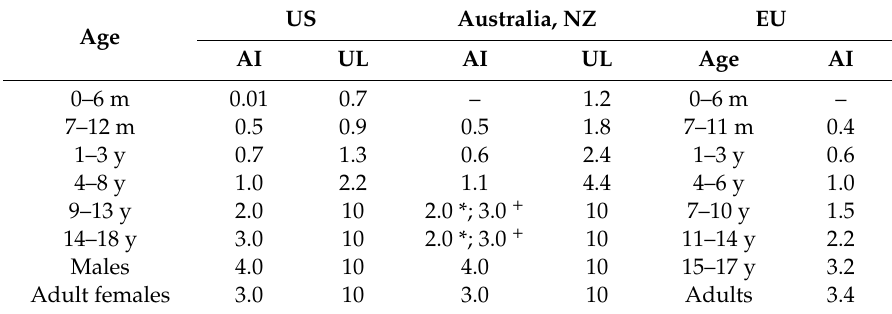
Table 4. Adequate intake (AI) and upper tolerable intake levels (UL) for F (in mg / day). According to the National Academies of Sciences, Engineering, and Medicine, US [101]; NHMRC, Australia and New Zealand [102]; and EFSA, EU